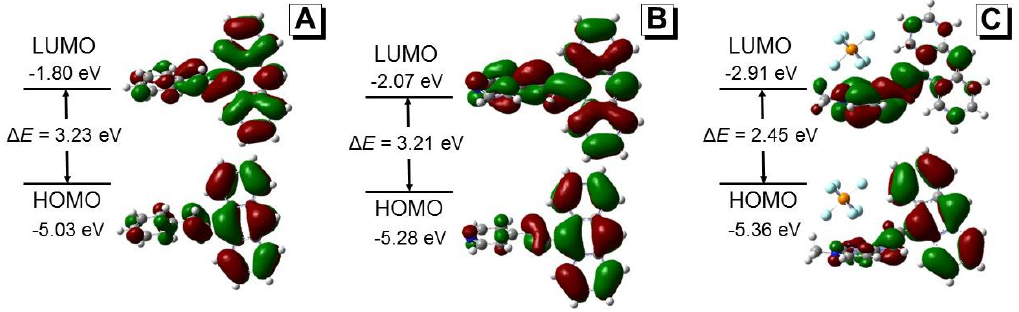
Figure 9. Molecular orbital amplitude plots and the HOMO/LUMO energy levels of 1 ( A ); 2 ( B ) and 3 ( C ) calculated using the B3LYP/6-31G basis set. 3 ( C ) calculated using the B3LYP/6-31G basis